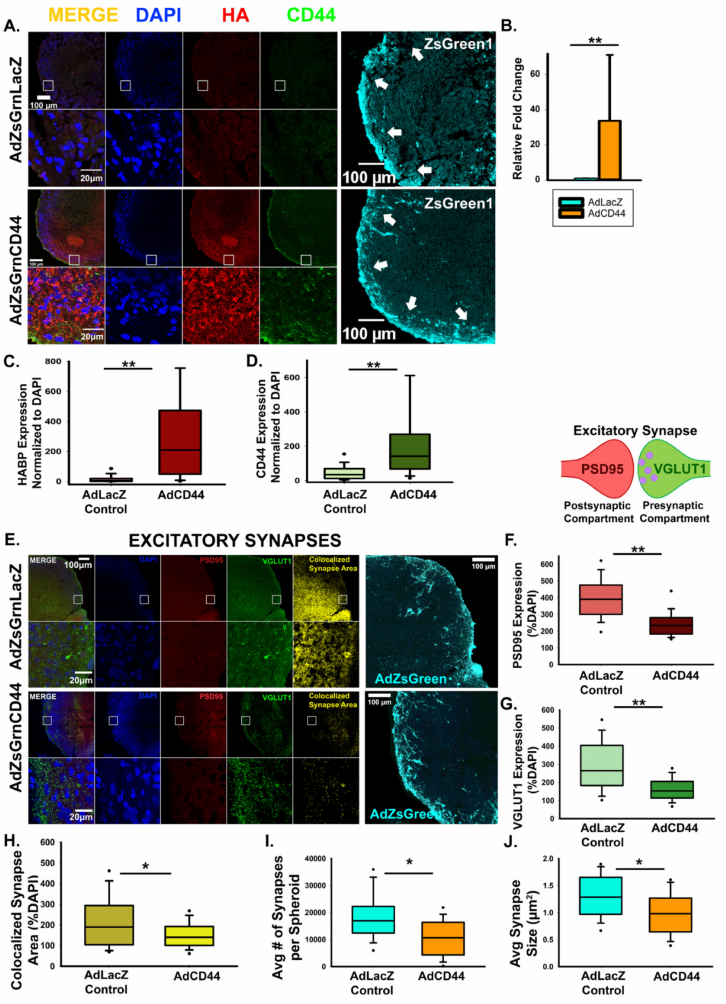
Figure 7. CD44 antagonizes excitatory synapse formation. ( A ) Representative images of cortical spheroids transduced with either LacZ control or CD44 and stained for DAPI (blue), HA (red), and CD44 (green). Highlighted region of the cortical plate is enlarged below. Successful transduction was confirmed via viral expression of the fluorophore, ZsGreen1 (cyan, far right panels). Arrows indicate the cortical plate, where synapse analysis was performed. Scale bars top: 100 µ m, enlarged